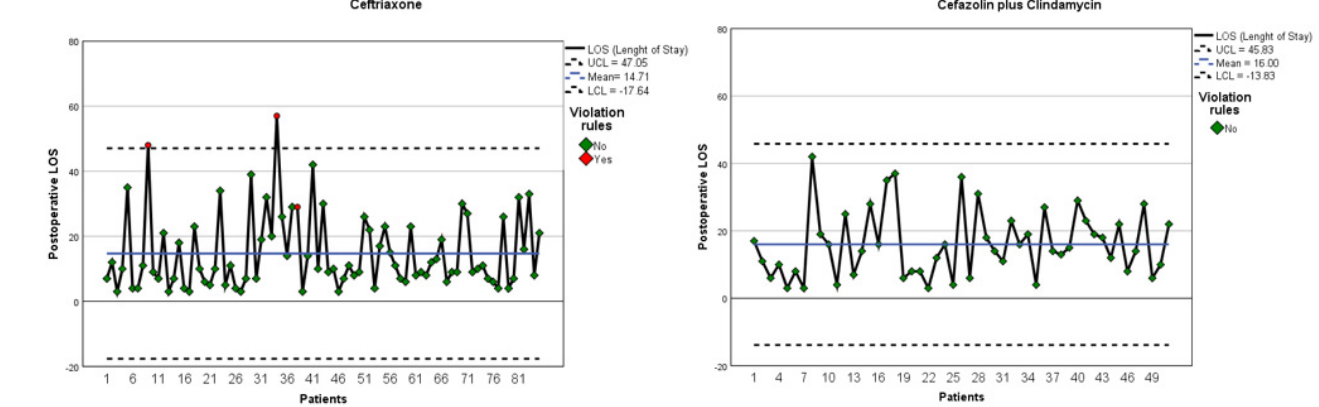
Figure 4. Control Chart before ( left ) and after ( right ) the new postoperative antibiotic protocol.